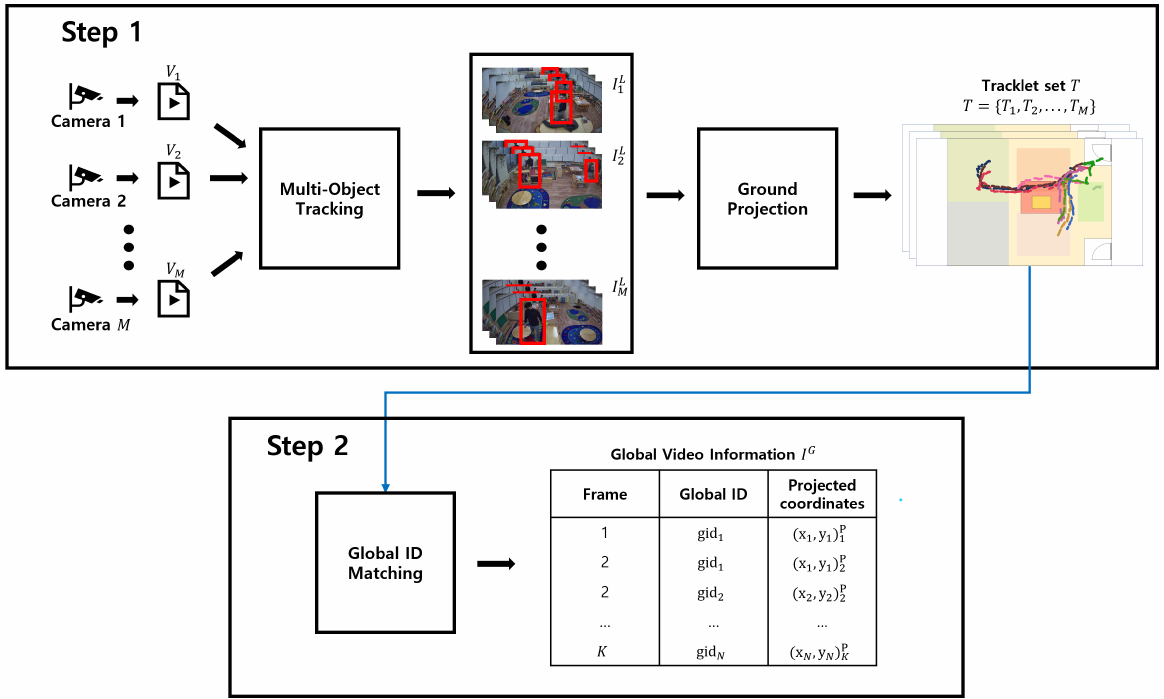
Figure 1. System